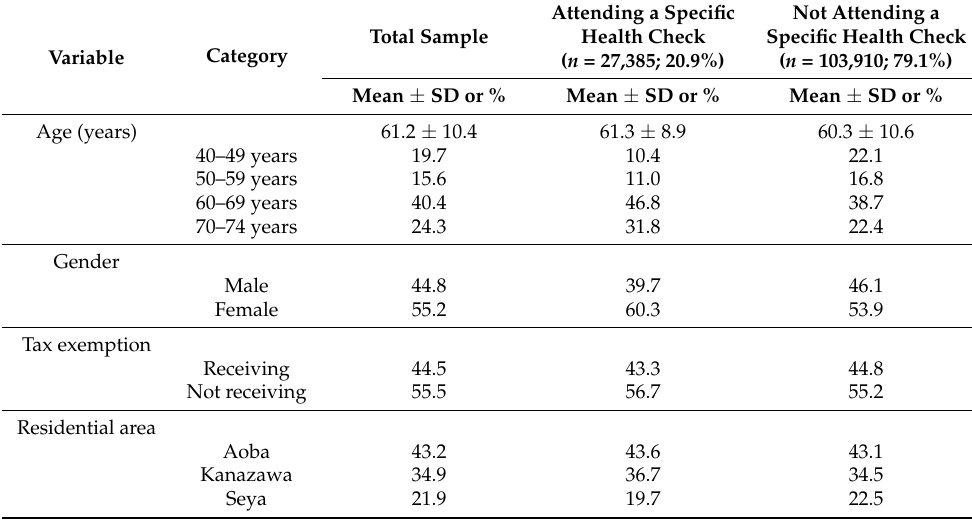
Table 1. Participant characteristics at baseline ( N = 131,295).